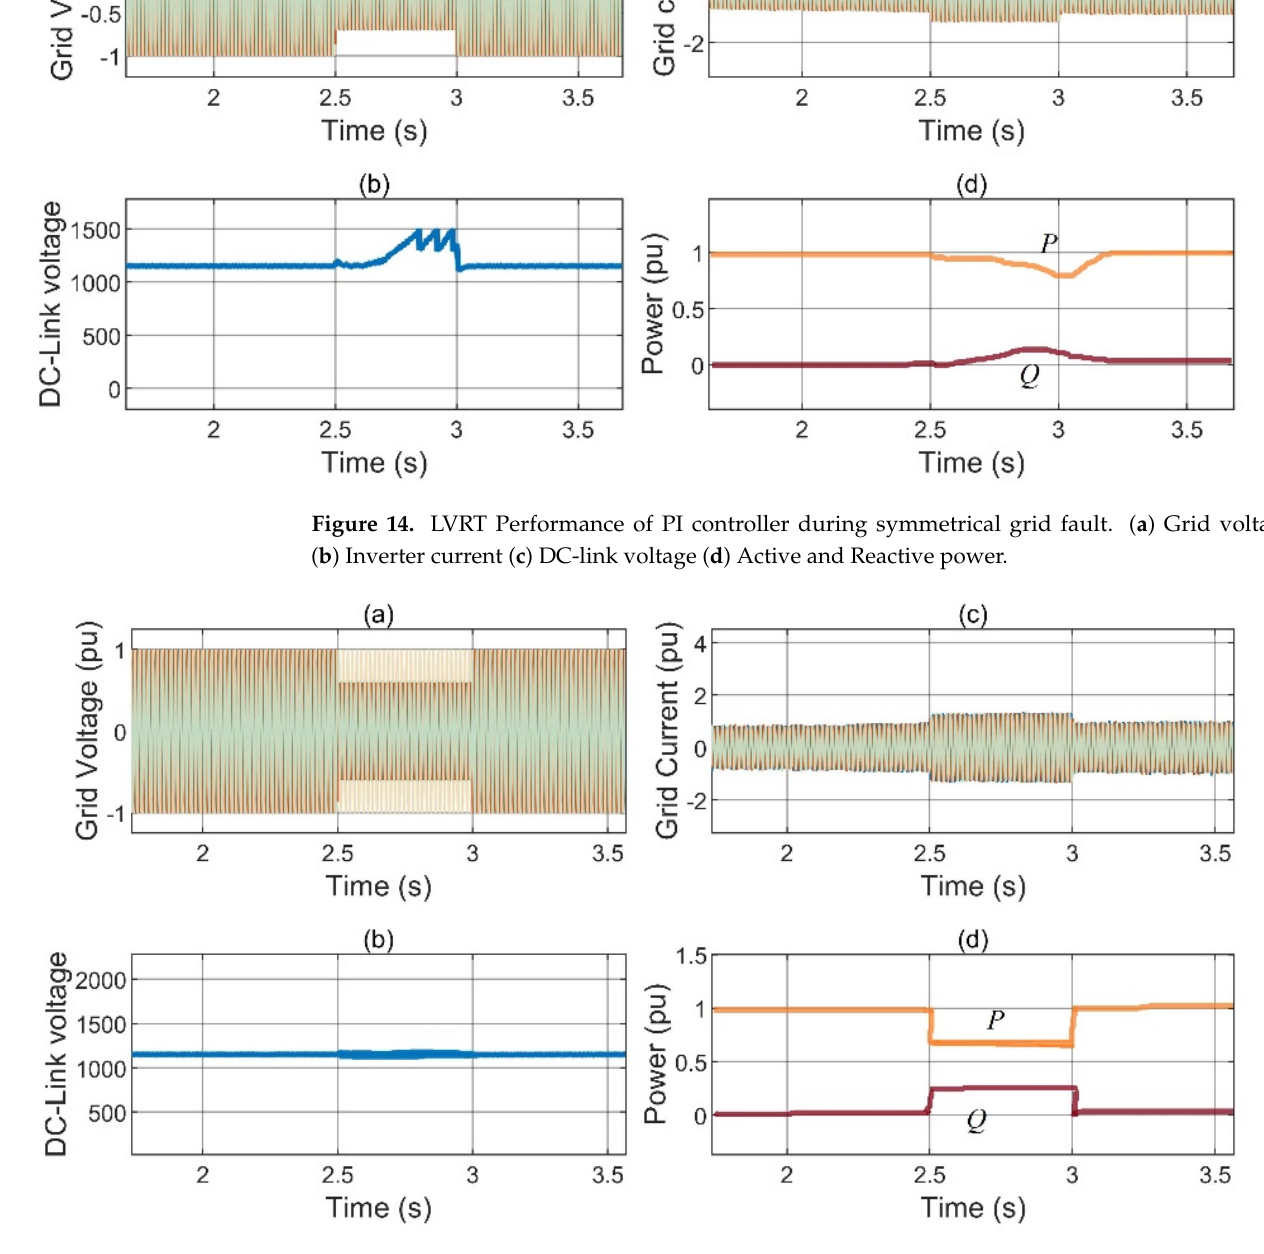
Figure 15. Enhanced LVRT capability of the proposed MPC scheme during asymmetrical grid